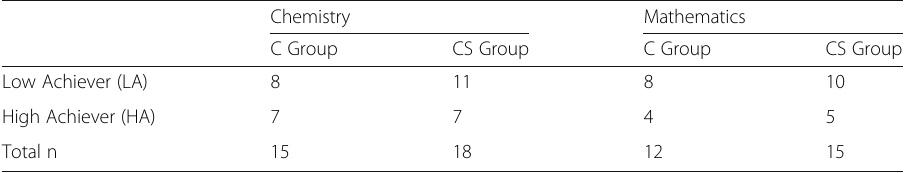
Table 2 Number of LA and HA Participants for Chemistry and